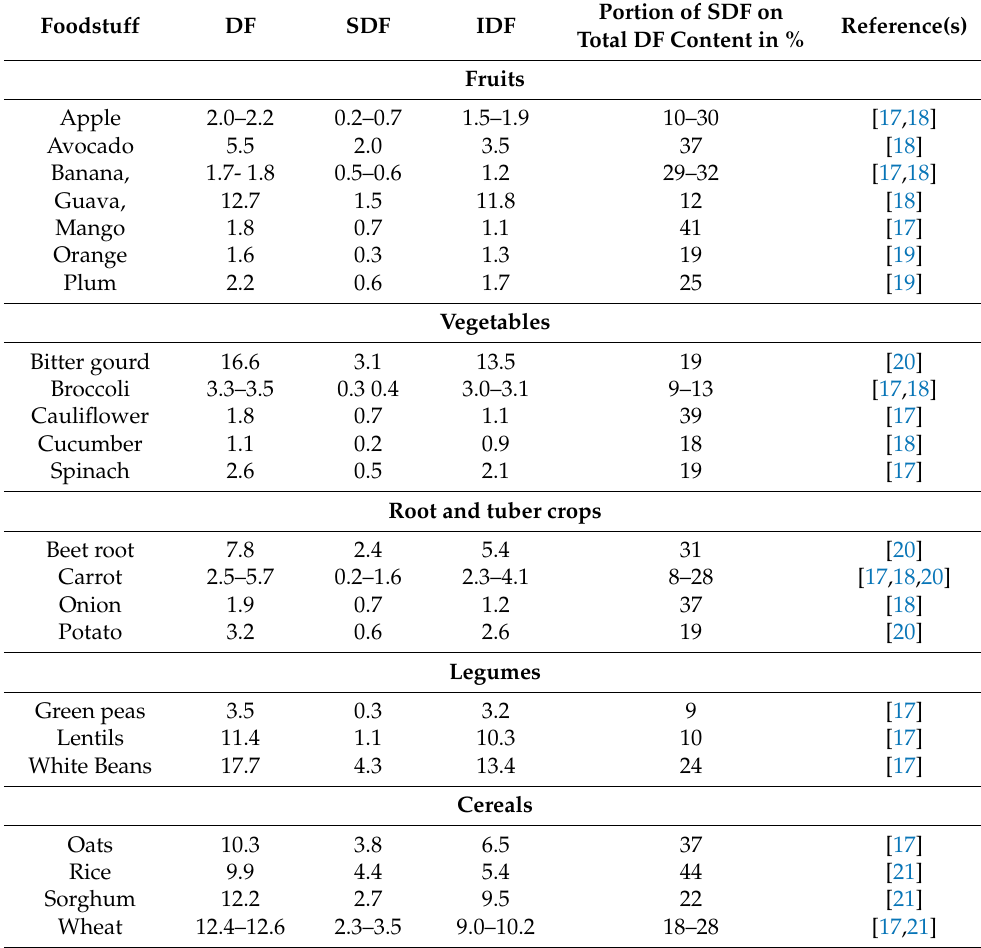
Table 2. Dietary fiber contents of several fruits, vegetables, root and tuber crops, legumes and cereals (DF, SDF and IDF contents are given in g/100